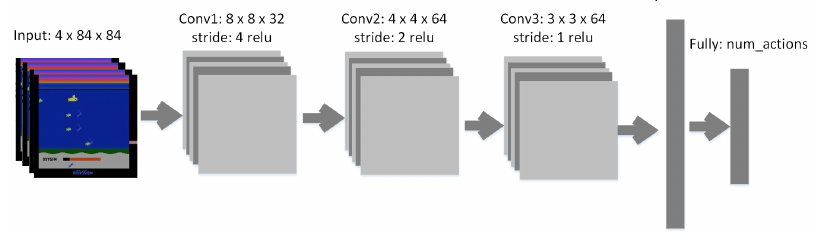
Figure 8. The network architecture of DDQN.